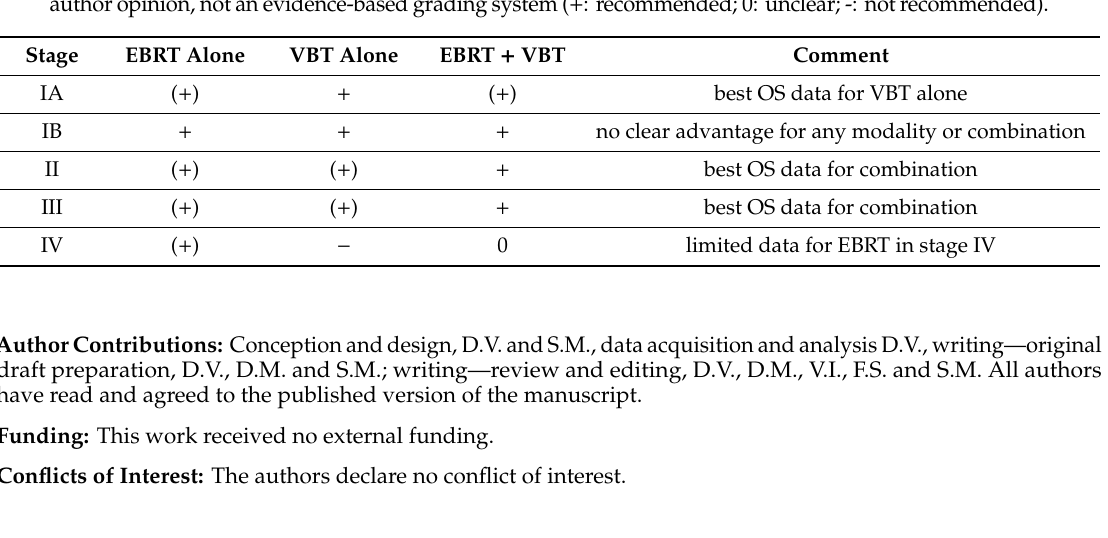
Table 4. Overview of recommendations derived in the present analysis regarding the use of